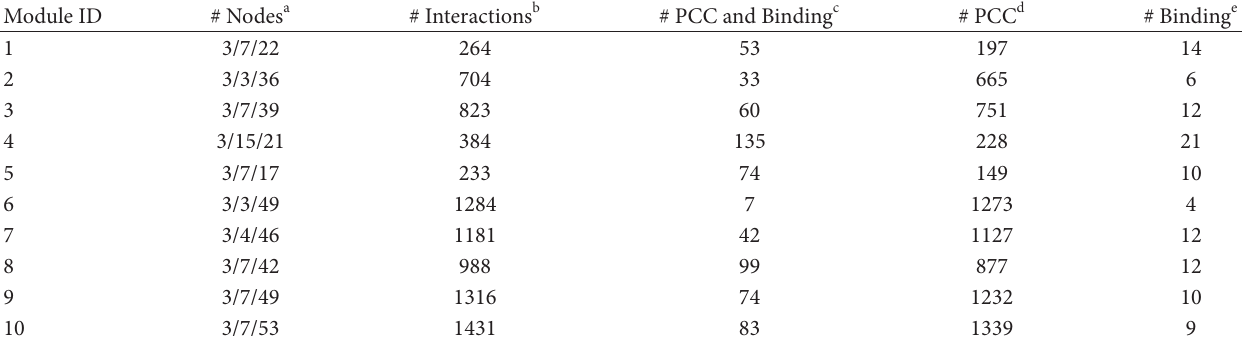
T 1: Summary of regulatory interactions in the 10 predicted modules for Dataset I.